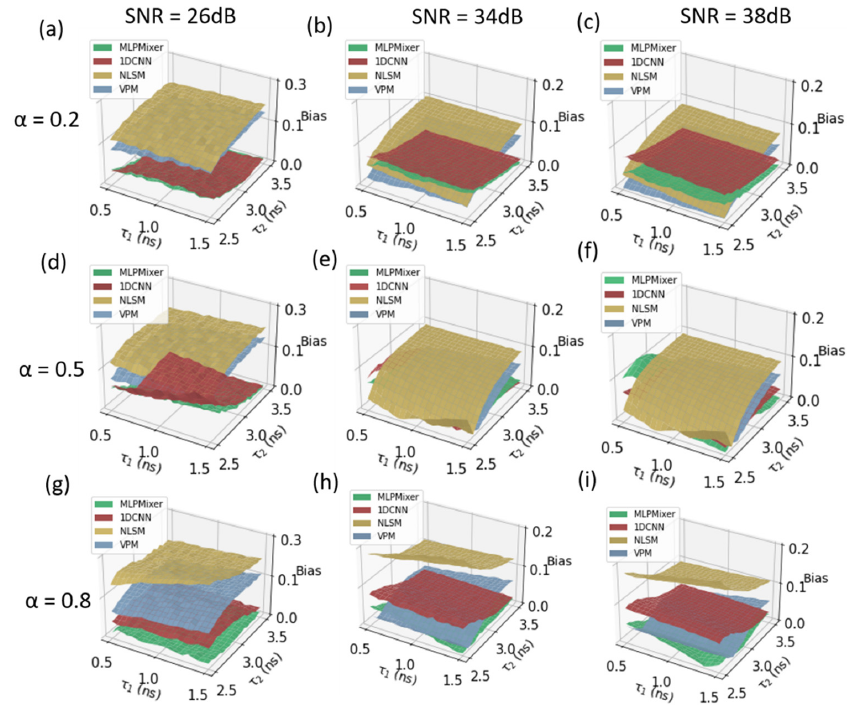
Figure 4. τ A estimation error planes of the MLP-Mixer, 1D-CNN, NLSM, and VPM at different fraction ratios α under different signal-to-noise ratios. For signals following a biexponential decay model where τ 1 ∈ ( 0.5, 1.5 ) ns , τ 2 (cid:101) ( 2.5, 3 ) ns . The error planes ( a , d , g ) SNR 26 dB, ( b , e , h ) SNR 34 dB, ( c , f , i ) SNR 38 dB, and α = 0.2, 0.5, 0.8.